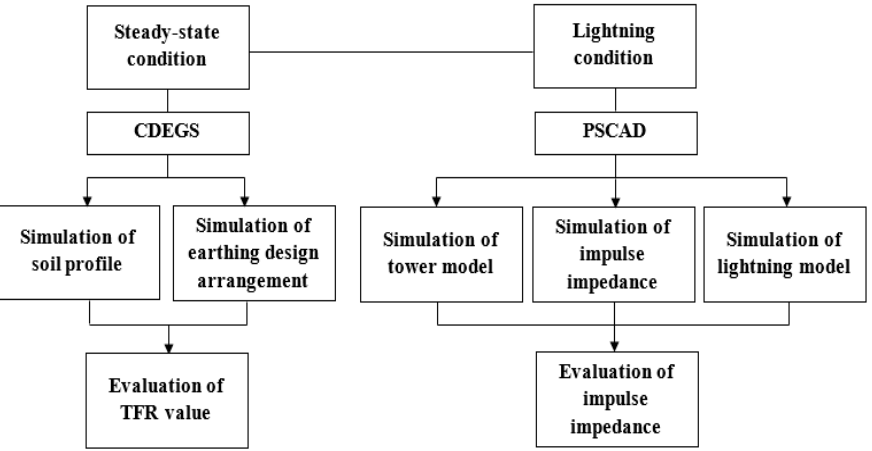
Figure 2. Summary of the simulation work in this study.